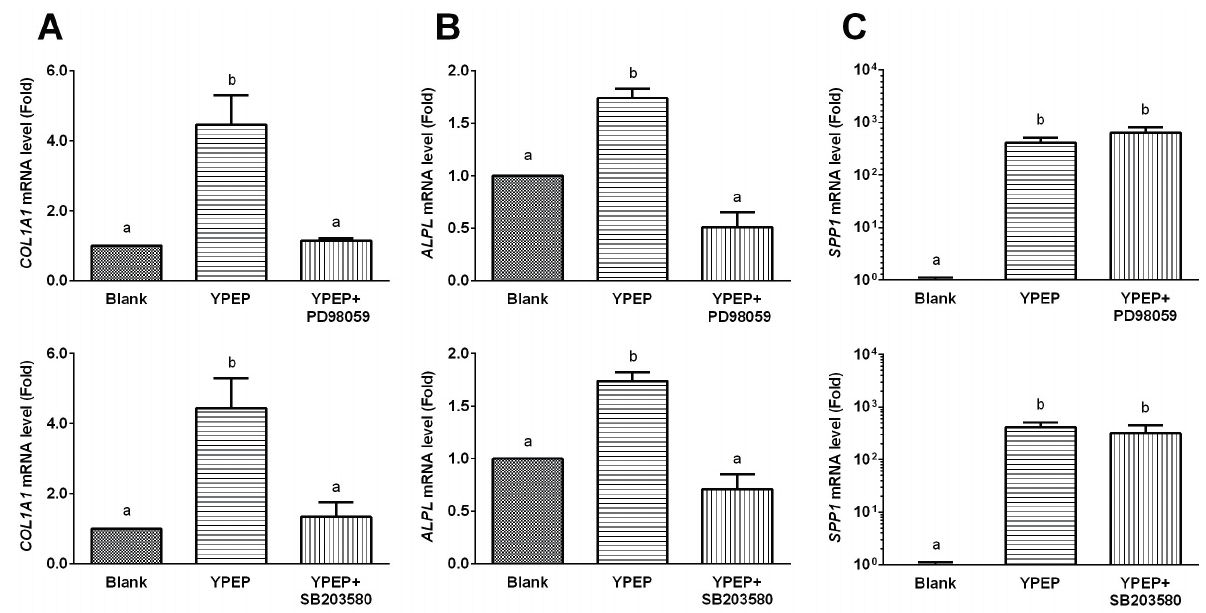
Figure 6. ( A – C 1st row) Effects of ERK inhibitor (PD98059) on COL1A1 (collagen, type I, alpha 1), ALPL (alkaline phosphatise), and SPP1 (secreted phosphoprotein 1, osteopontin) gene expressions. ( A – C 2nd row) Effects of p38 inhibitor (SB203580) on COL1A1 , ALPL , and SPP1 gene expressions. All data are expressed as mean ± SD of the three cultures. Values not sharing a common alphabet as superscripts are significantly different from each other at the level of p < 0.05.